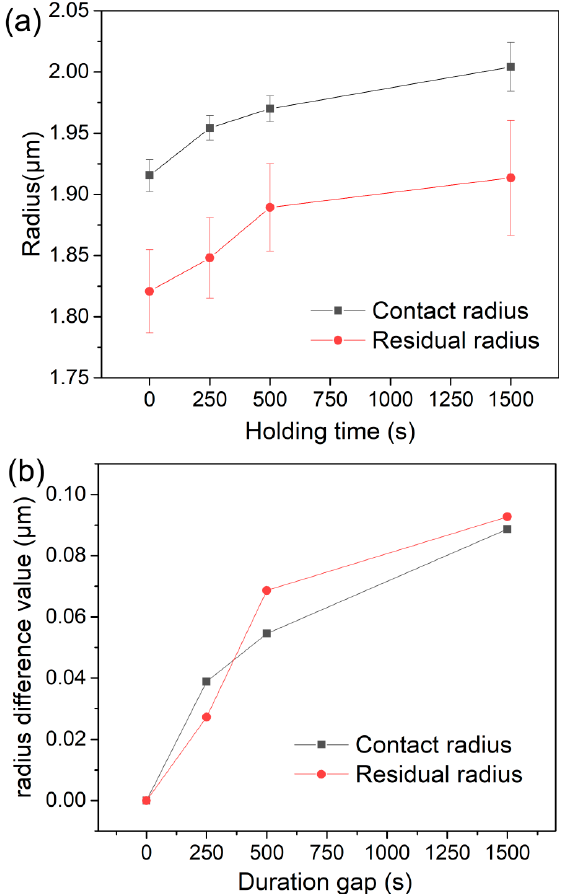
Figure 4. ( a ) The residual radii measured from scanning electron microscope (SEM) observation and the contact radii at the end of holding stage, which were plotted with holding time. ( b ) The increased values of contact and residual radii after holding stage. Micromachines 2020 , 11 , x